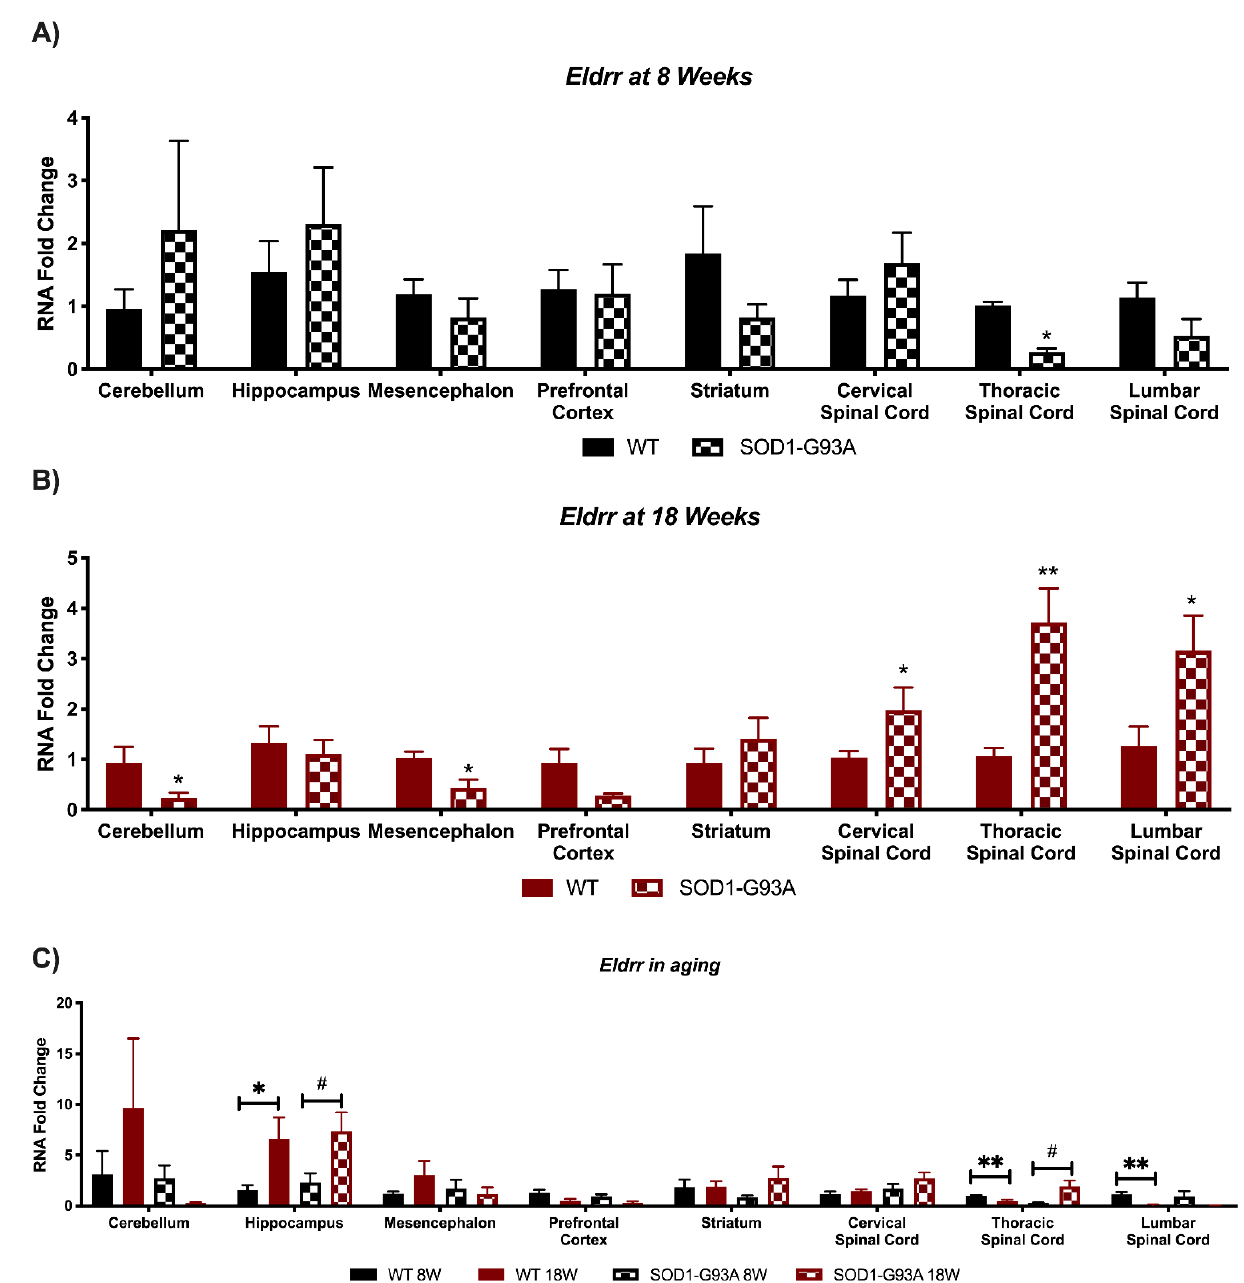
Figure 6. Alterations in Eldrr expression in SOD1-G93A mice and during murine development. RNAs expression levels were evaluated by Real Time-PCR in the different conditions. Data are expressed as mean ± SEM. ( A ) Eldrr expression in 8 weeks old WT ( n = 6) mice versus 8 weeks old SOD1-G93A mice ( n = 6). * p < 0.05 vs. WT. ( B ) Eldrr expression in 18 weeks old WT ( n = 6) mice versus 18 weeks old SOD1-G93A mice ( n = 6). * p < 0.05, ** p < 0.01 vs. WT. ( C ) Eldrr expression in 8 weeks old WT mice versus 18 weeks old WT ( n = 6) and 8 weeks old SOD1-G93A mice versus 18 weeks old SOD1-G93A mice ( n = 6). * p < 0.05, ** p < 0.01 vs. WT 8W, # p < 0.05 vs. SOD1-G93A 8W.